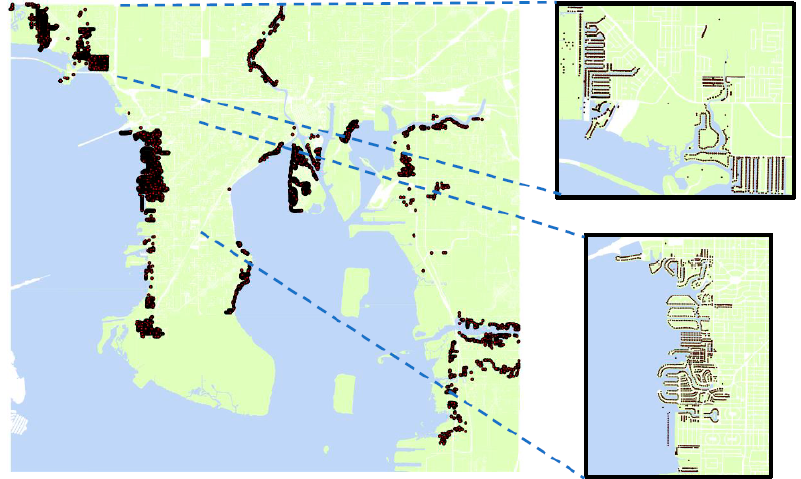
Figure 5. Flooded residential properties by 2150 in the high-end warming scenario. The most two flooded areas are detailed in the right two subfigures. Each black dot denotes one property to be flooded due to sea level rise.